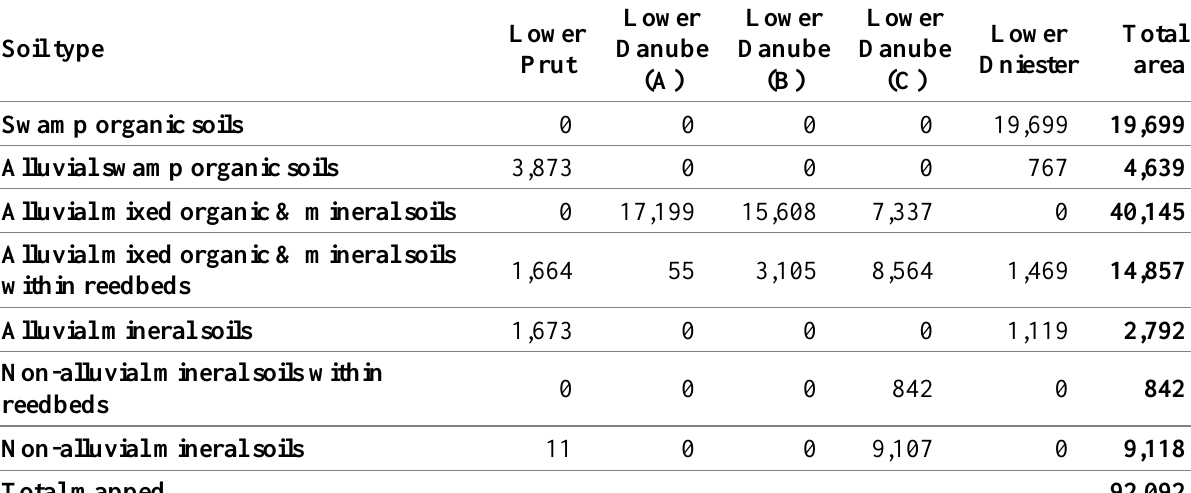
Table 2. Extent of soil types in the ReedBASE study sites (figures in ha, rounded). Source: ReedBASE project.